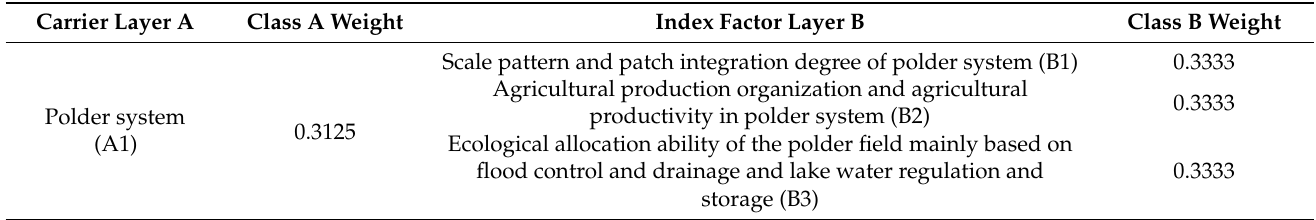
Table 6. Assessment scale of cultural landscape value quality in the demonstration